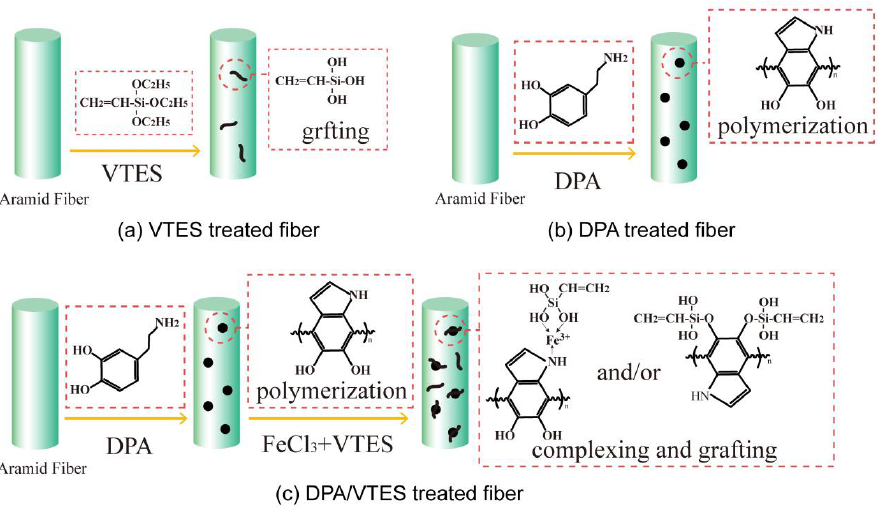
Figure 3. Procedures for CAF modification: ( a ) vinyl triethoxysilane-treated, ( b ) dopamine-treated, and ( c ) dopamine and vinyl triethoxysilane-treated.